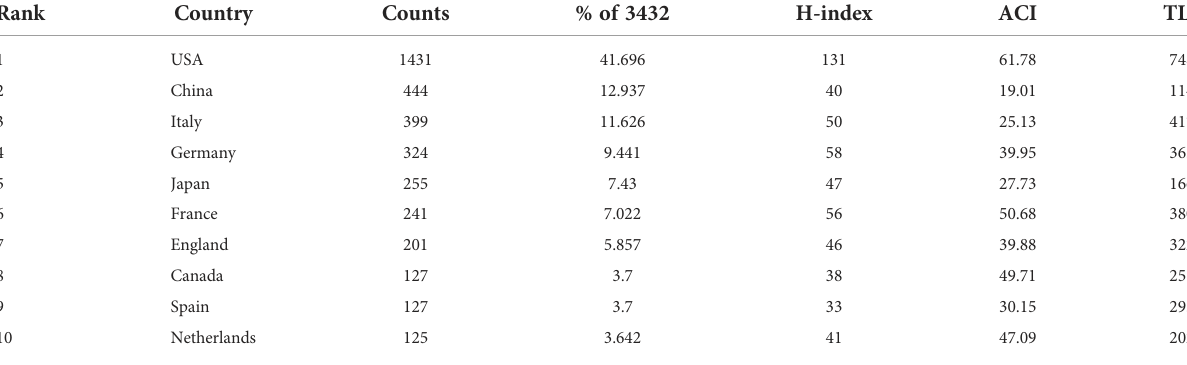
TABLE 1 Top 10 productive countries/regions related to RCC immunotherapy